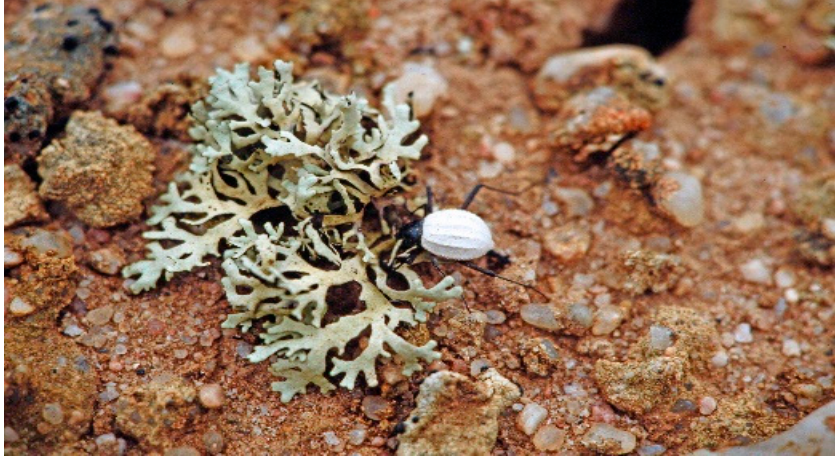
Figure 9. Cauricara eburnea feeding on lichen in the fog zone northwest of Gobabeb.